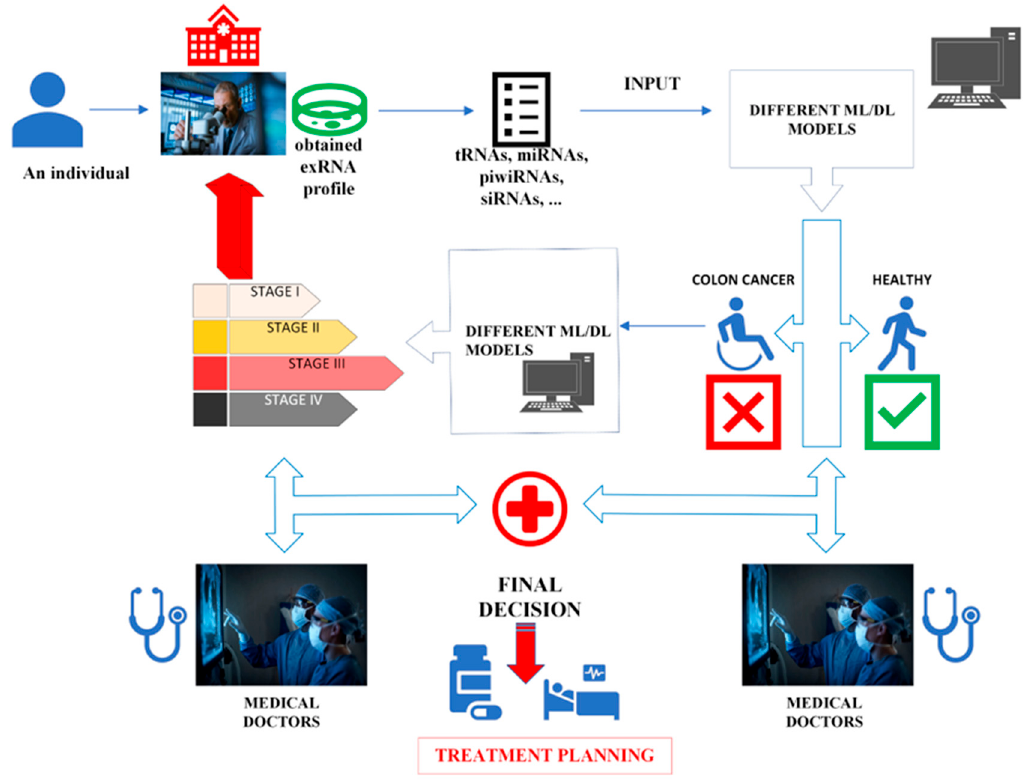
Figure 11. Practical applicability of the proposed approach. (Illustrations by the